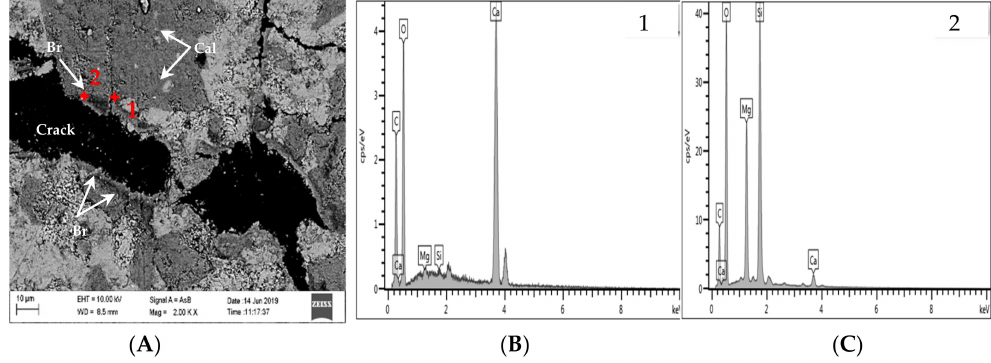
Figure 15. BSE and EDS images of products in concrete bars cured in 1 mol / L TMAH at 80 ◦ C: ( A ) BSE image of the products; ( B ) EDS image of calcite; ( C ) EDS image of